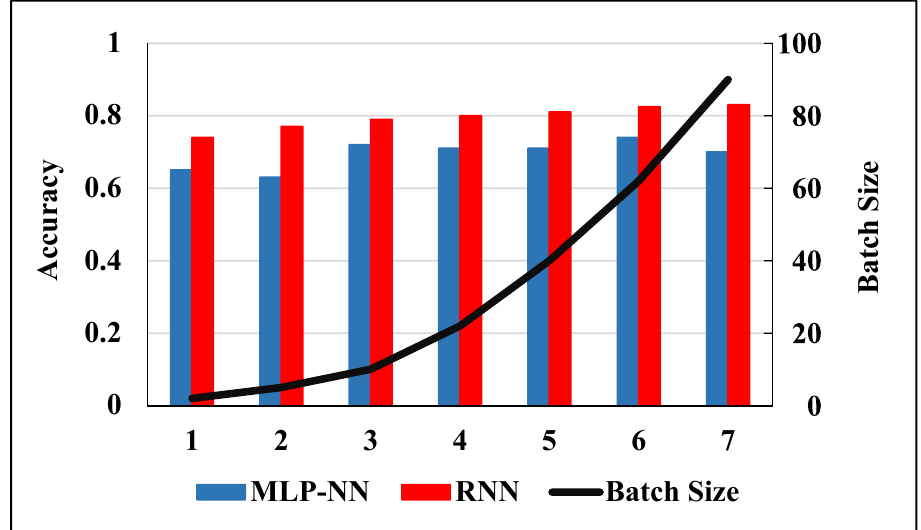
Figure 12. Impact of batch size on the performance of the MLP-NN and RNN